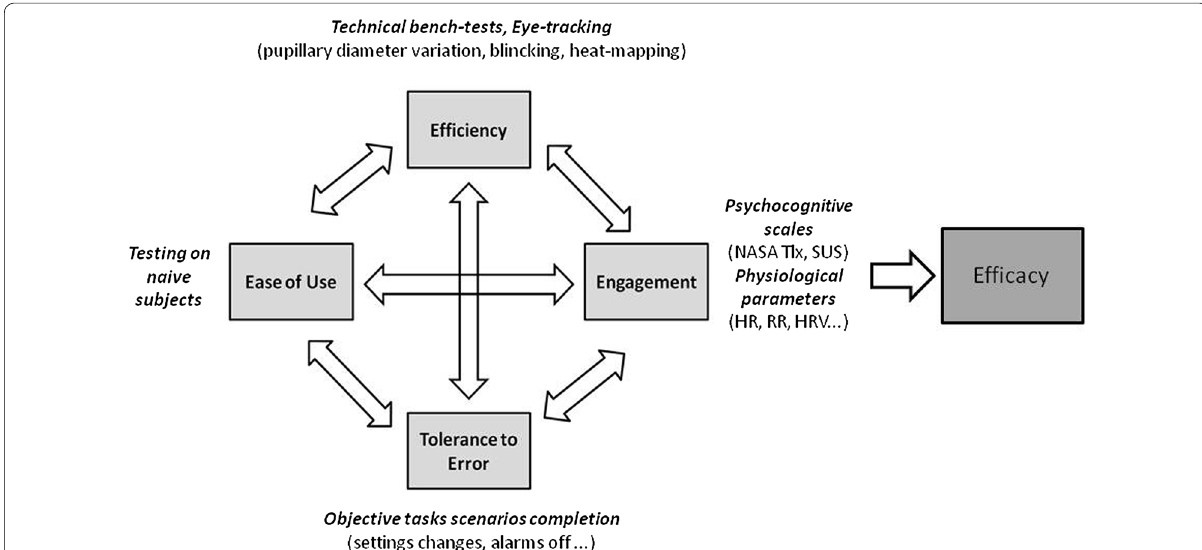
Fig. 1 The concept of devices’ global evaluation. In order to assess ‘ efficacy ’ of a device, we considered that a global ergonomics evaluation required evaluating concomitantly ‘ efficiency ’, ‘ engagement ’, ‘ ease of use ’ and ‘ tolerance to error ’, as these four dimensions may be considered as